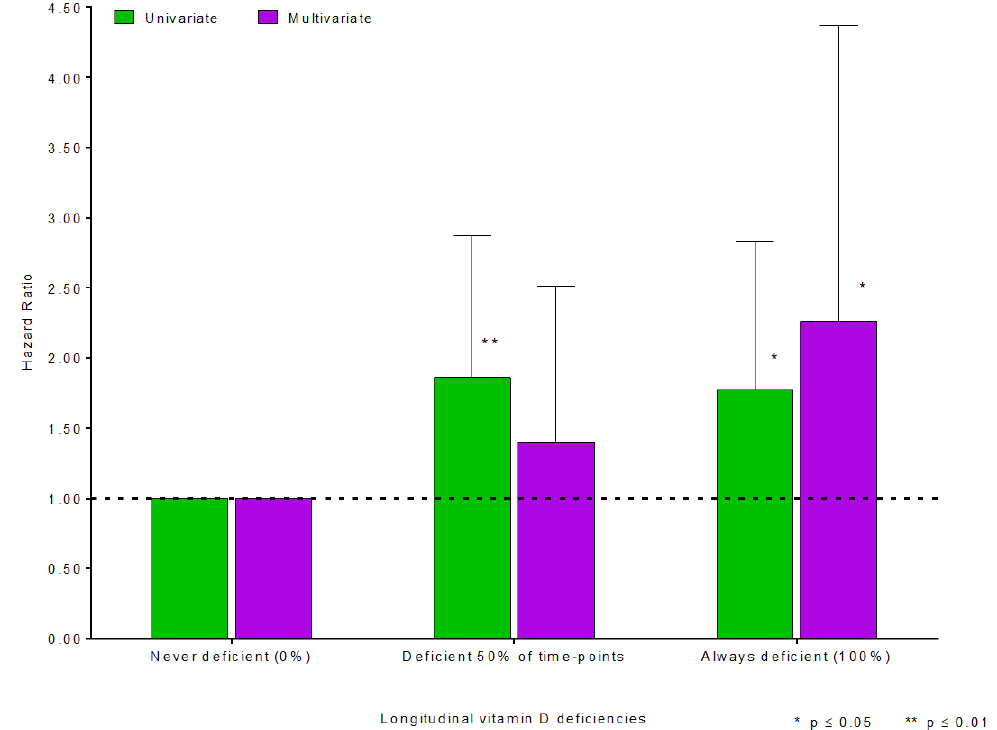
Figure 3. Hazard ratios of the association between longitudinal severe vitamin D deficiency and liver-related events (mortality and transplantation). The reference group is never deficient patients, and the vertical lines denote 95% con- fidence intervals around the hazard ratio estimates. Hazard ratios are adjusted for the serum levels of ALT, ALP, bilirubin, and creatinine; sex; ascites; variceal bleeding; BMI ≥25 kg/m 2 ; development of high-grade strictures; and hepatobiliary malignancy. 3.5. Response to Vitamin D Supplementation Regardless of vitamin D status at diagnosis, 195 patients were prescribed various vit- amin D regimens with doses ranging from megadoses of 500,000 international units (IUs) to 50,000 IU of vitamin D2 or 4000 to 400 IUs of D3. The mean level of vitamin D was 59 ± 2 nmol/L at baseline, which improved to 77 ± 3 nmol/L in supplemented patients ( p < 0.00;